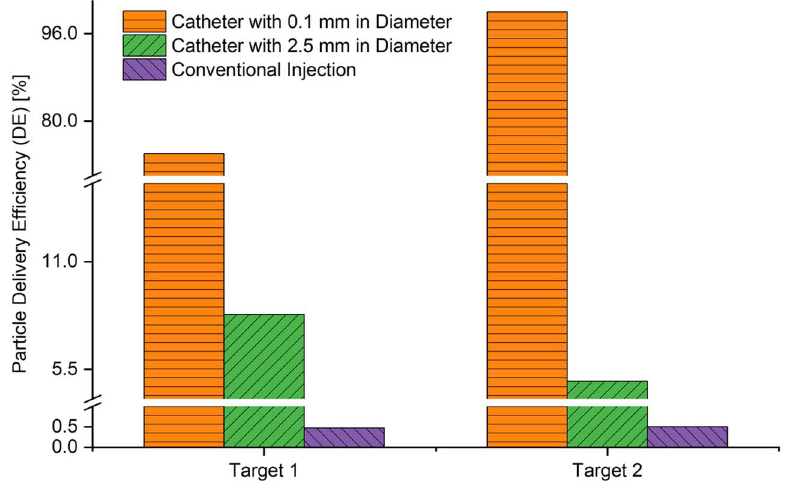
Figure 5. Comparison of targeted particle DEs on both tumors between conventional injection method and controlled particle injection methods using catheters with different diameters.